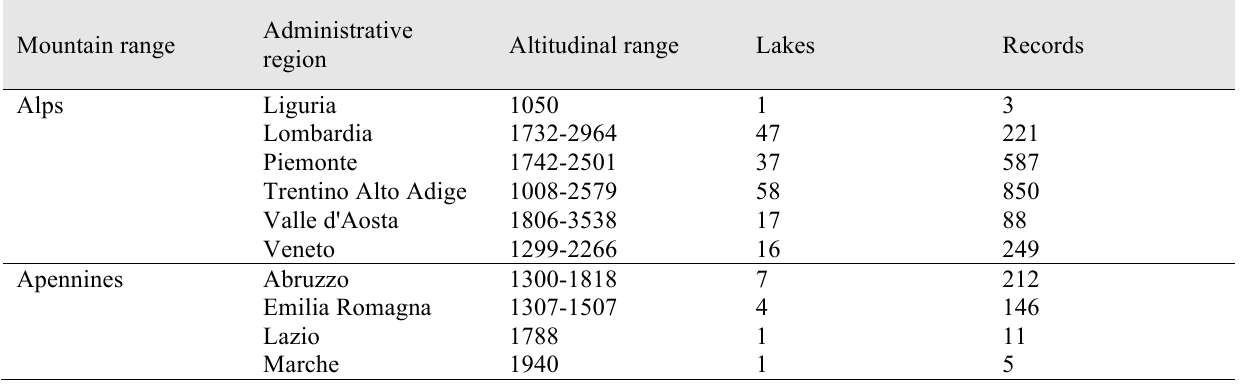
Table 2. Number of records distributed among mountain range, administrative region, altitudinal range, and number of lakes for the Alps and the Apennines.